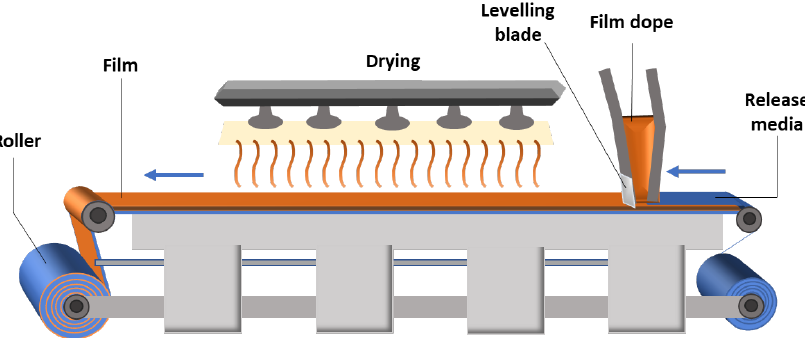
Figure 9. Scheme of industrial production of a polymeric film using the solvent casting technique (adapted from [168]).